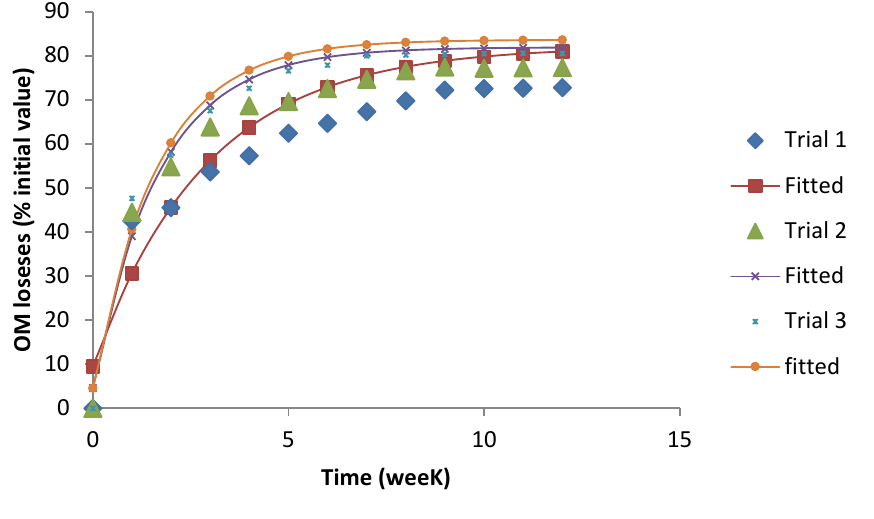
Fig. 7 Organic matter losses during composting. Lines represent curve-fitting Table 3 Parameters of first-order kinetic equations for organic matter loss during composting Compost